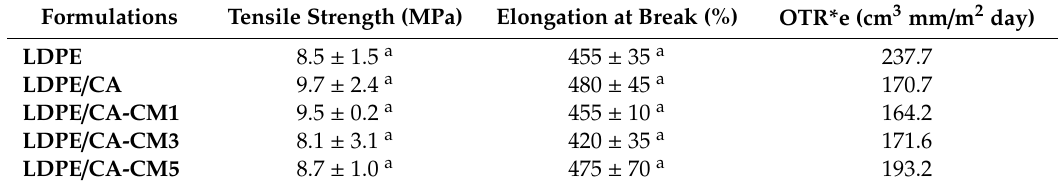
Table 4. Tensile test and oxygen barrier properties of LDPE / CA-CM-based